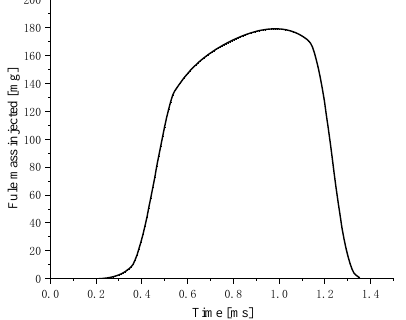
Figure 2. The fuel injection rate @2500 rpm, 1800 bar, 0.78 ms.